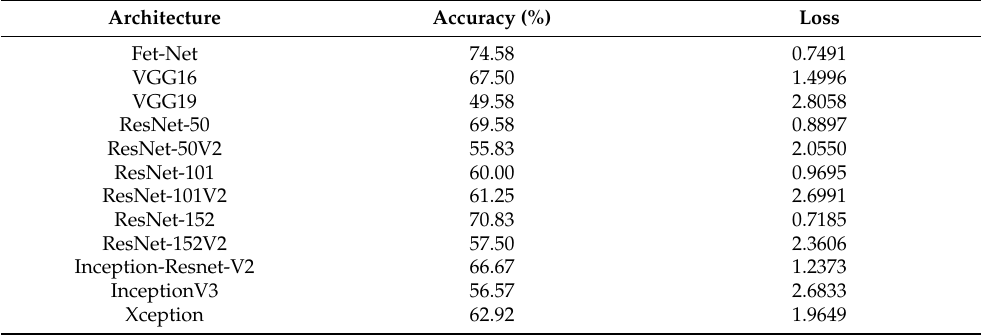
Table 5. Summary of performance metrics of Fet-Net and prominent CNN architectures with a decreased SNR testing